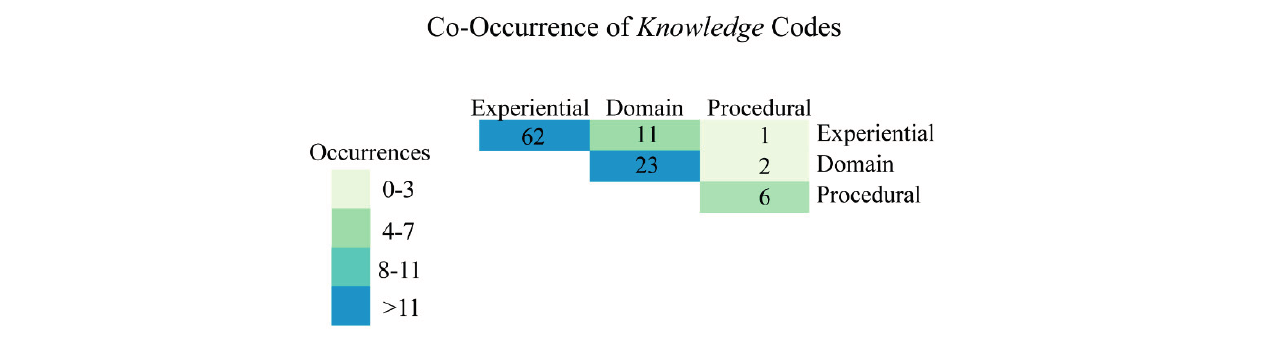
Figure 4. The occurrence of Knowledge codes.